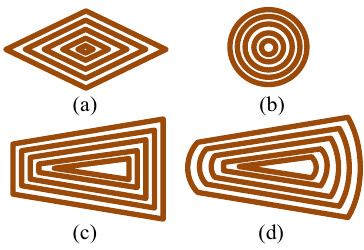
Figure 22 Winding structures: a Rhomboidal, b Circular, c Trapezoidal, and d